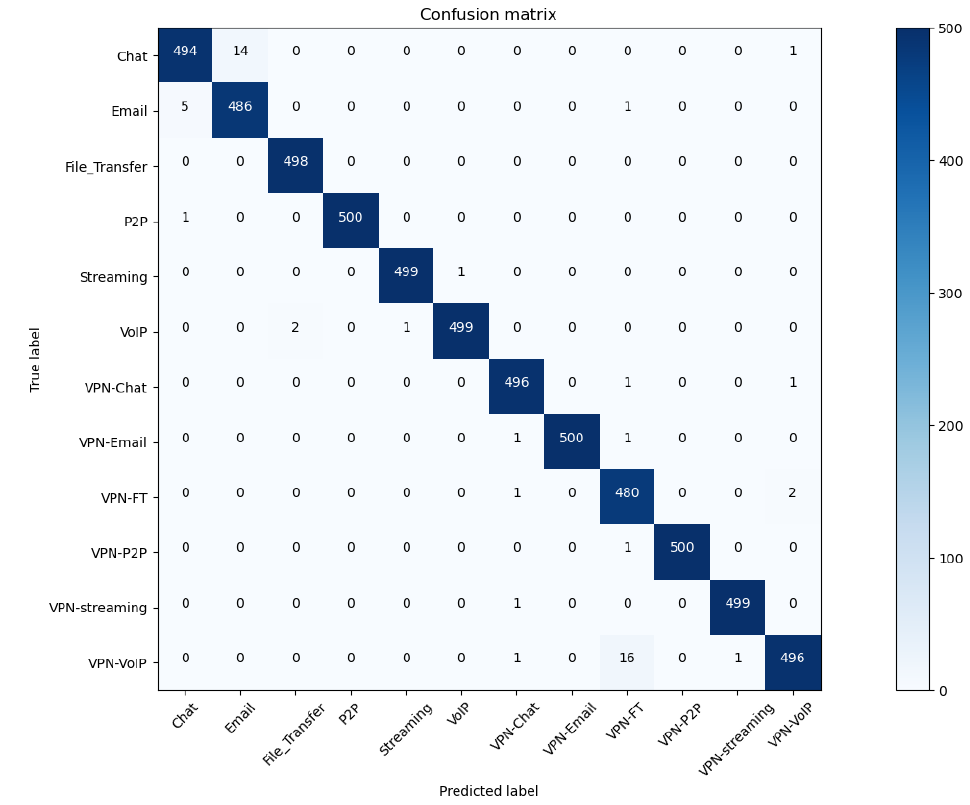
Figure 3. Confusion matrix for service identification tasks.